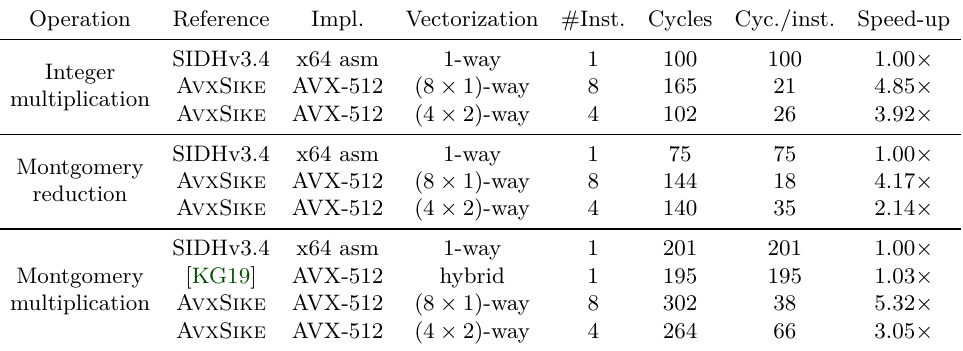
Table 1: Experimental results of F p -arithmetic operations for SIKEp503